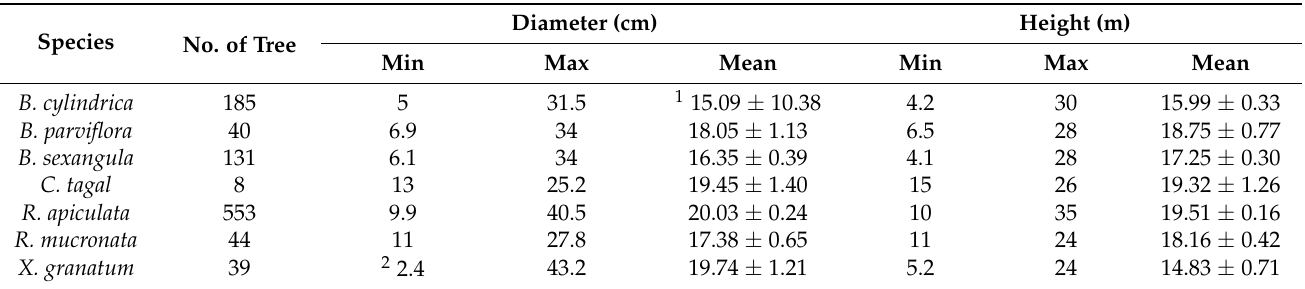
Table 4. Summary of descriptive statistics for aboveground biomass 1000 standing trees in Sg. Pulai Forest